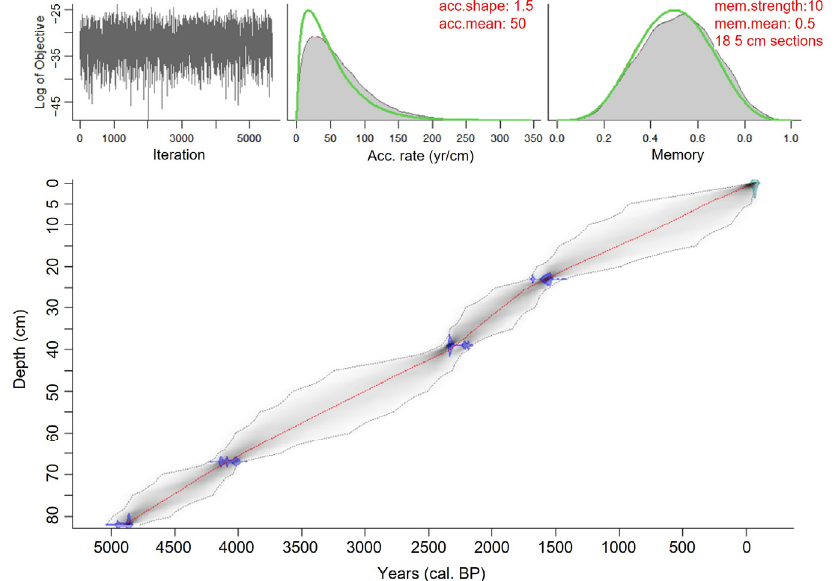
Figure 2. Bayesian age-depth model of Oakes Bay West Lake. The top panels represent, from left to right: MCMC iterations (model stability), prior (green lines) and posterior (gray) distributions for accumulation rate (middle panel), and model memory properties (right panel). The calibrated ages of the 4 dated samples ( 14 C) and their probability distribution are shown in blue. The grey area bounded by the dashed lines represents the age model with the 2 σ (95%) confidence interval, and the red line indicates the weighted mean age corresponding to the most probable date.